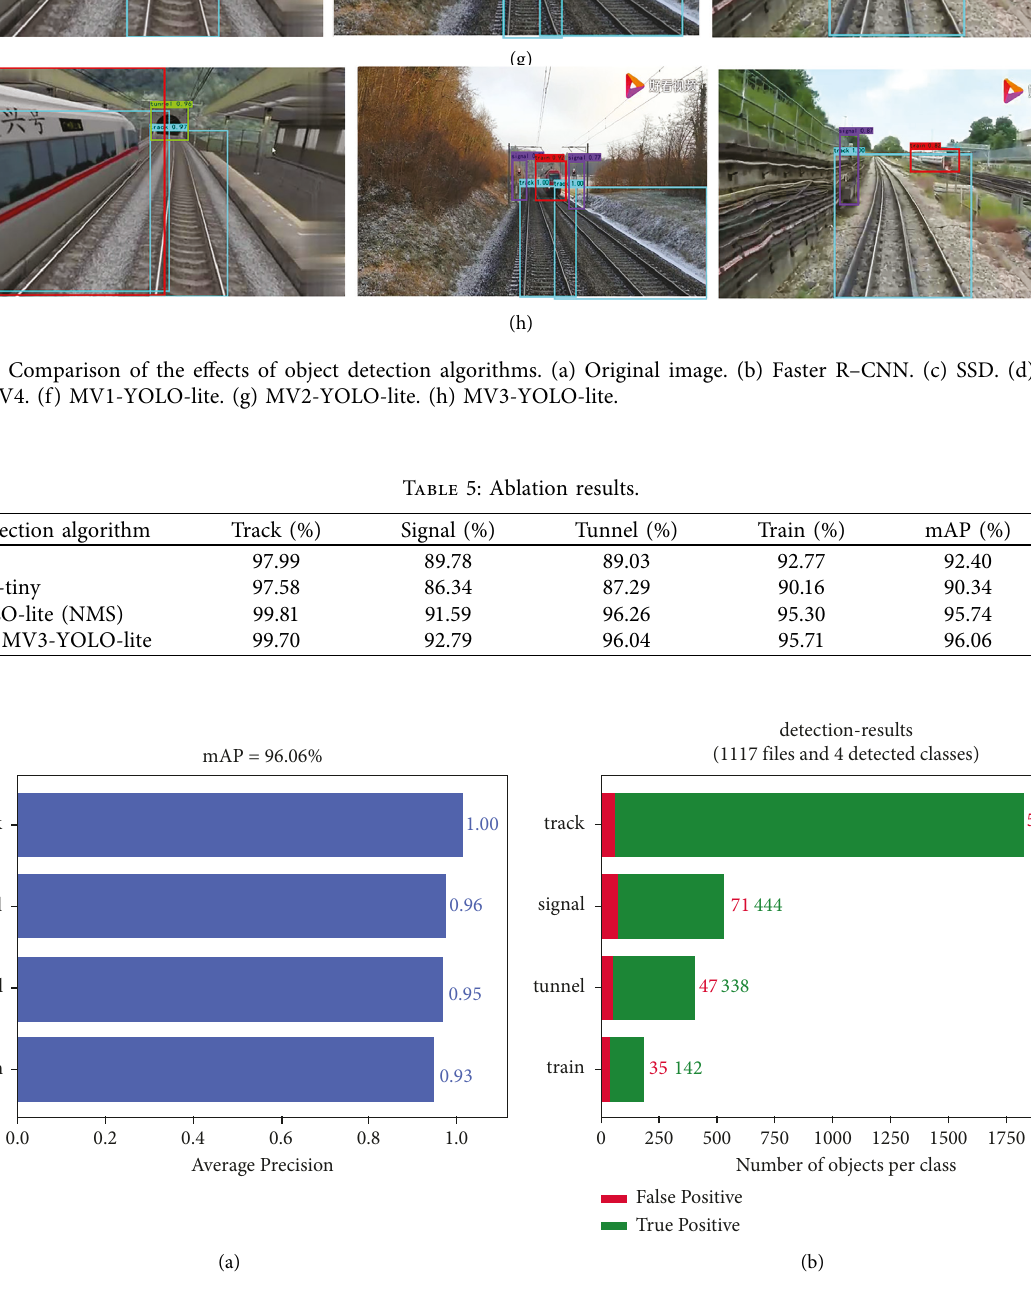
Figure 13: The prediction results of the MV3-YOLO-lite of Soft-NMS model. (a) mAP values and (b) the prediction